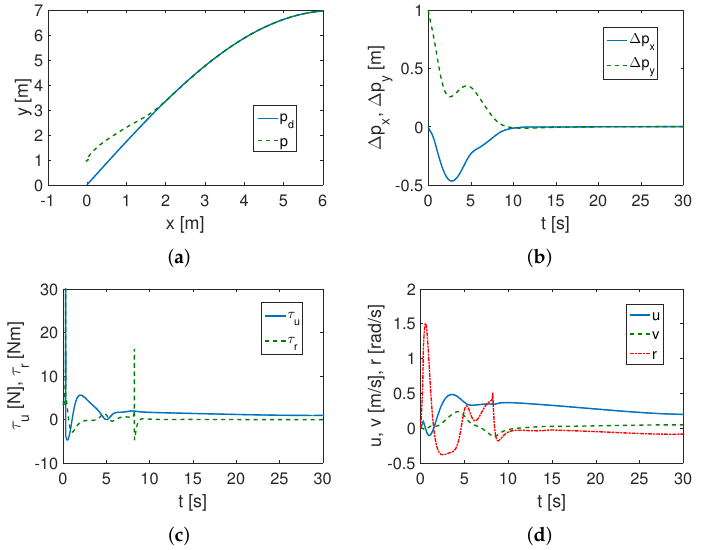
Figure 5. Simulation results for TSMC and sine trajectory (without friction): ( a ) desired ( p d ) and realized ( p ) trajectory; ( b ) position errors ∆ p x , ∆ p y (in inertial frame); ( c ) input signals components (applied force and torque) τ u , τ r ; ( d ) actual velocities u , v , r .